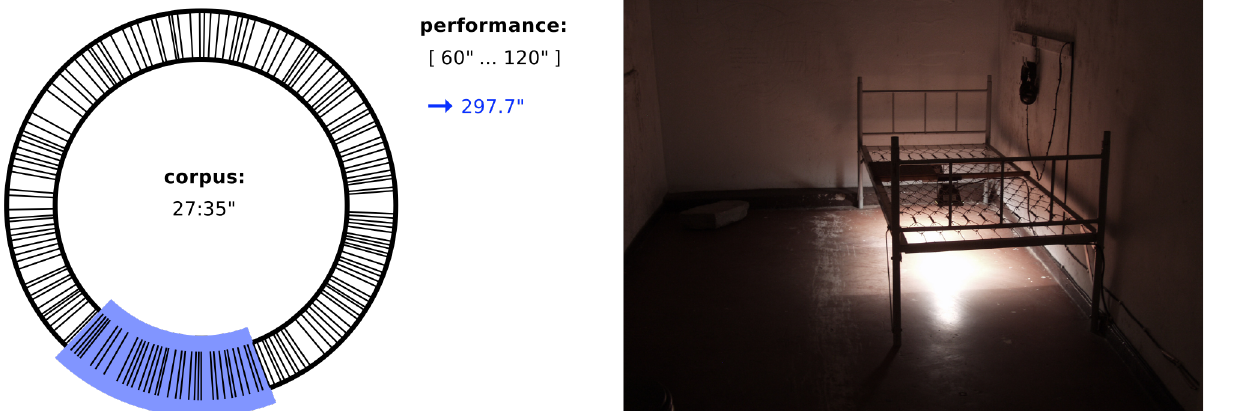
Figure 2 | A mobile sound structure (left) in the sound installation Zelle 148 (2006; right). From a virtual data pool of half an hour of recorded sound, the notated duration is between one and two minutes. One actual rendering of five minutes is shown in blue. Spikes indicate resting